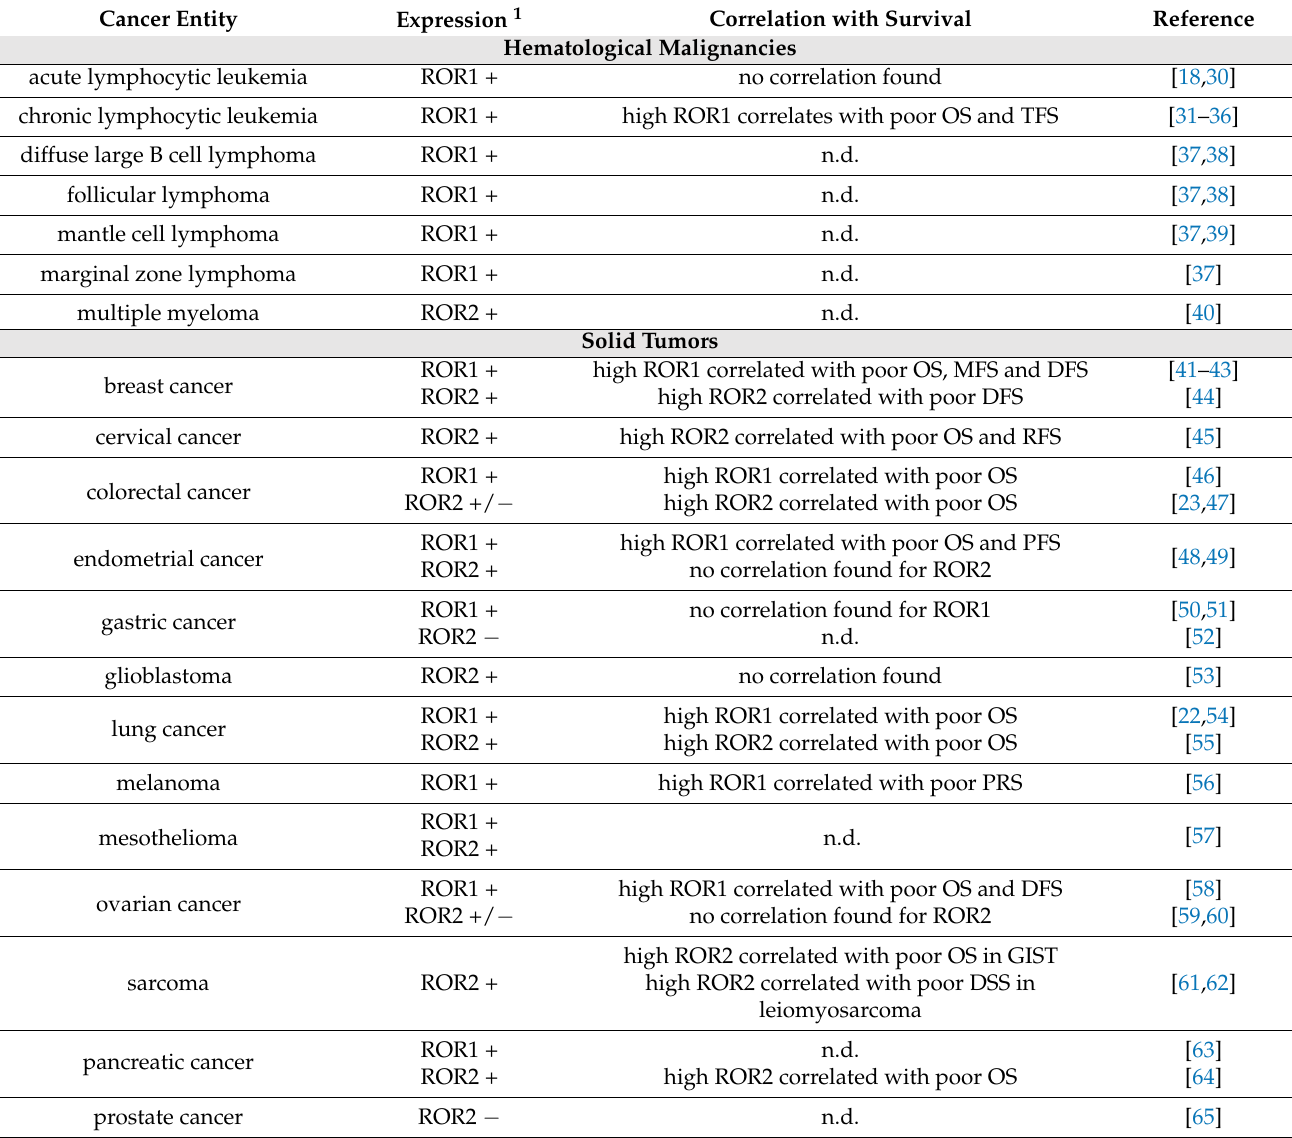
Table 1. Expression of ROR1 and ROR2 in